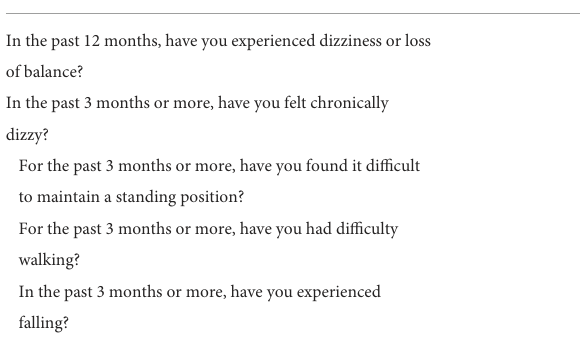
TABLE 1 Questionnaire about chronic